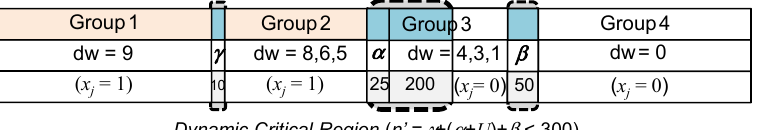
Figure 14. An example of robust unbiased filtering before applying DPT-List TSR on n ’ in K 1 and K 2 . ( a ) ( b )